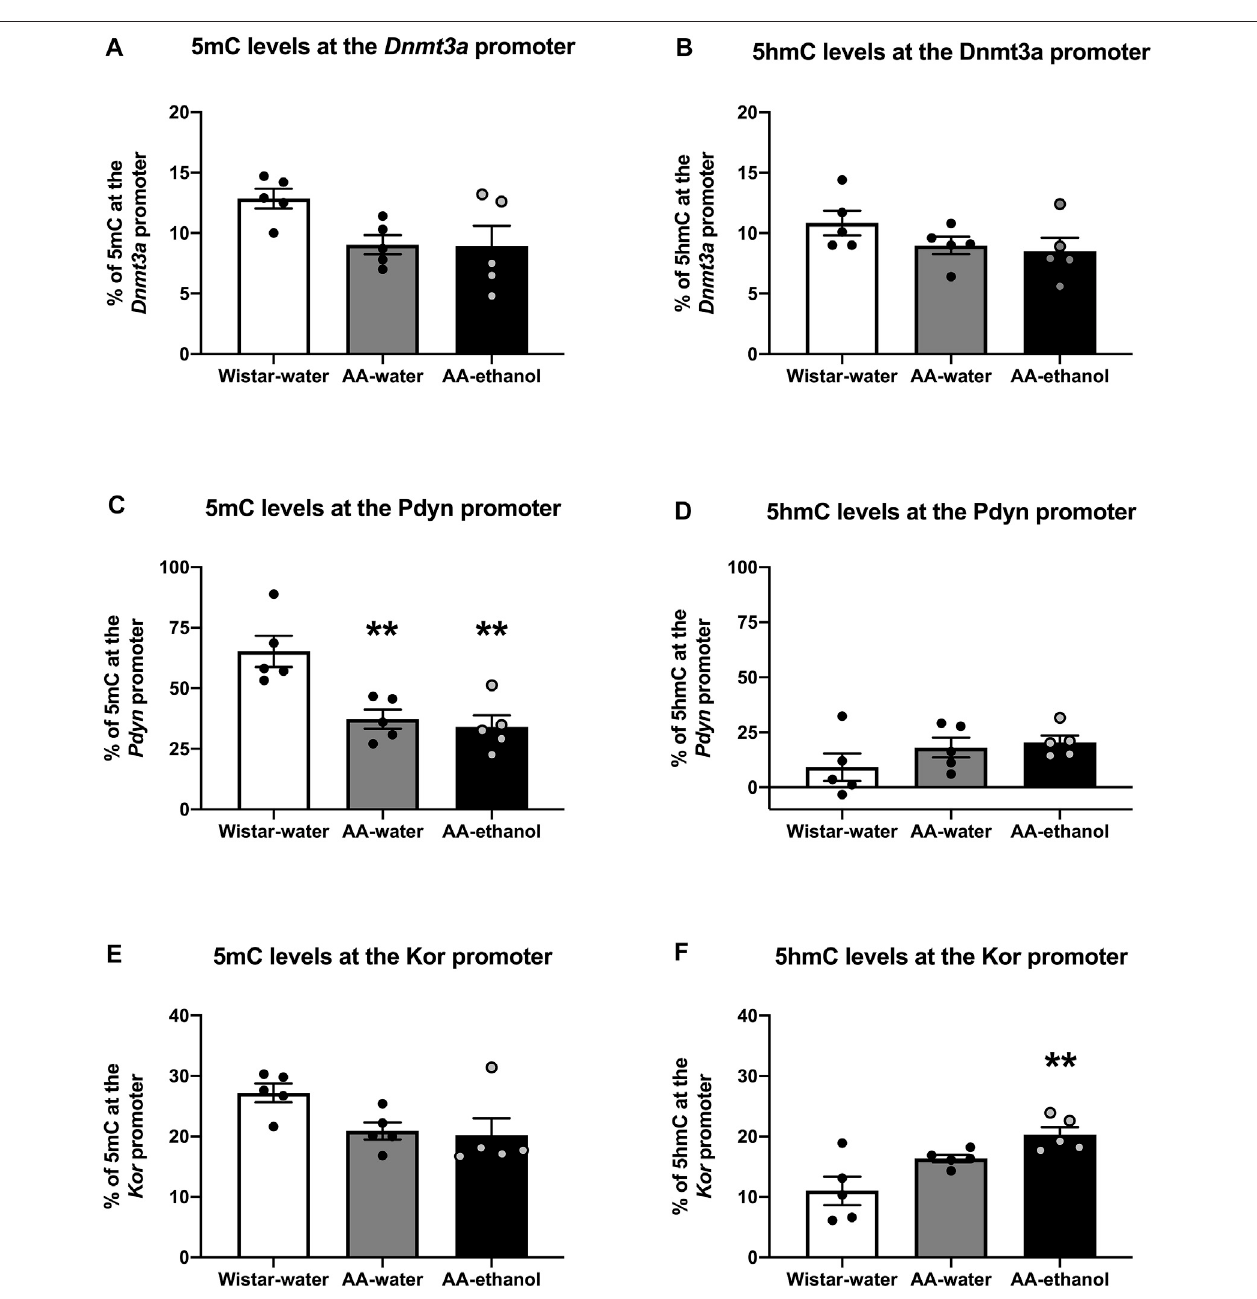
FIGURE 5 | Promoter region methylation (5mC%) (A,C,E) and hydroxymethylation (5hmC %) (B,D,F) levels in the NAc. One-way ANOVA followed by Tukey ’ s multiple comparisons test; ** p < 0.01, compared with the Wistar-water group; n (cid:2) 5 – 7. Error bars indicate SEM.